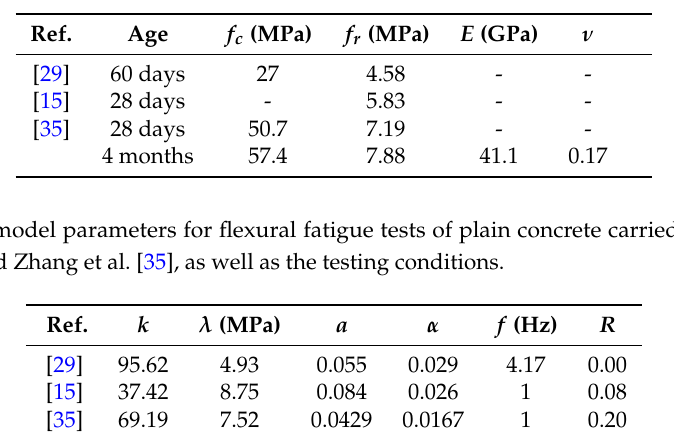
Table 2. Measured compressive strength, f c , and flexural strength, f r , for the plain concrete tested by Oh [29], Shi et al. [15] and Zhang et al. [35].